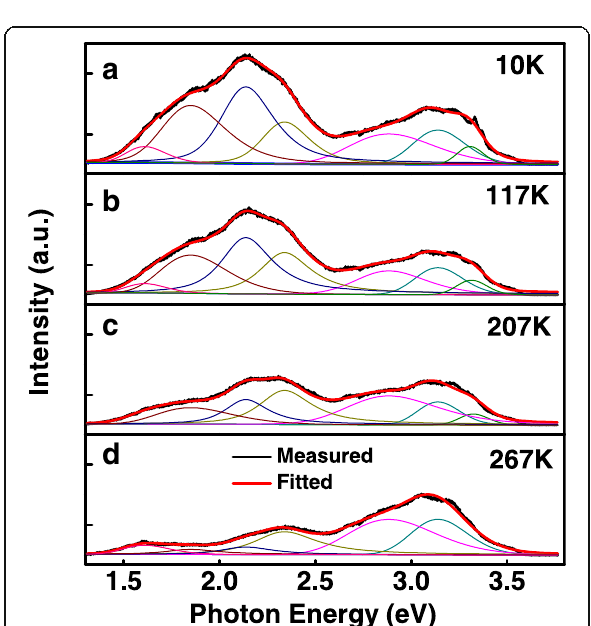
Fig. 8 Peak fitting of PL spectra of 0.08M AZO nanospears measured at a 10, b 117, c 207 and d